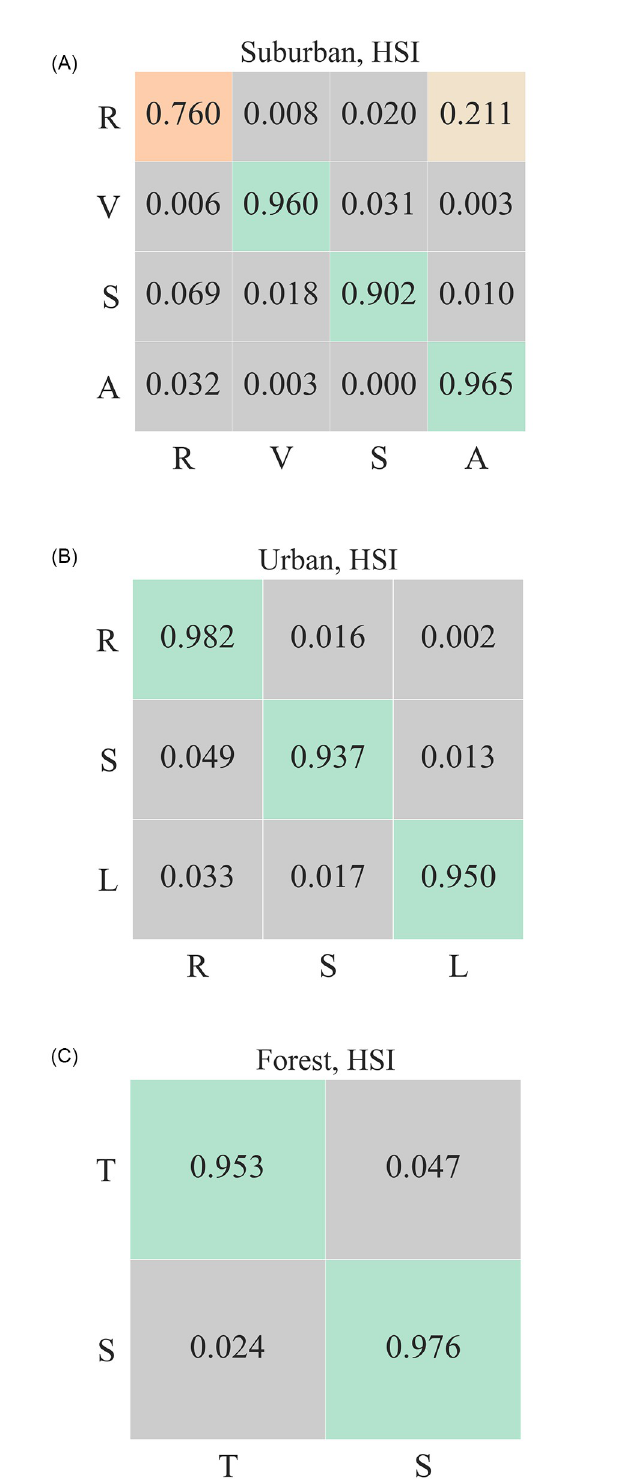
Fig 7. Confusion matrix for classification scores for three datasets using HSI data. (Left) R, V, S, and A refer to Rooftop, Vegetation, Shadow, and Asphalt; (Center) R, S, L refer to Rooftop, Shadow and Lawn respectively; and (Right) T, S refer to Tree and